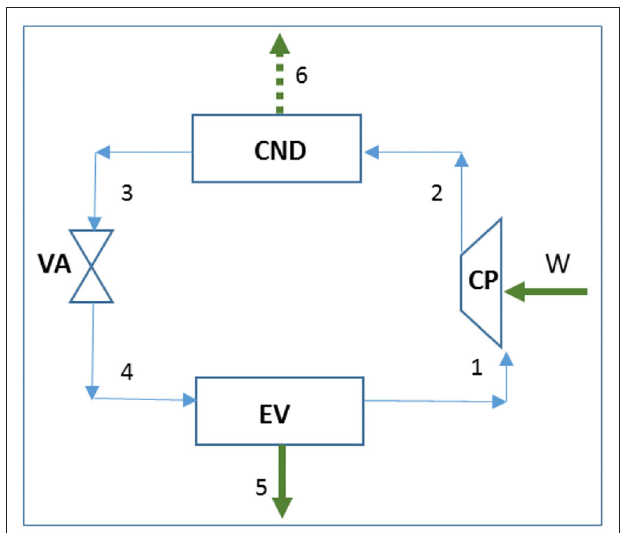
FIGURE 1 | Scheme of a vapor compression refrigeration system, where exergy flows are